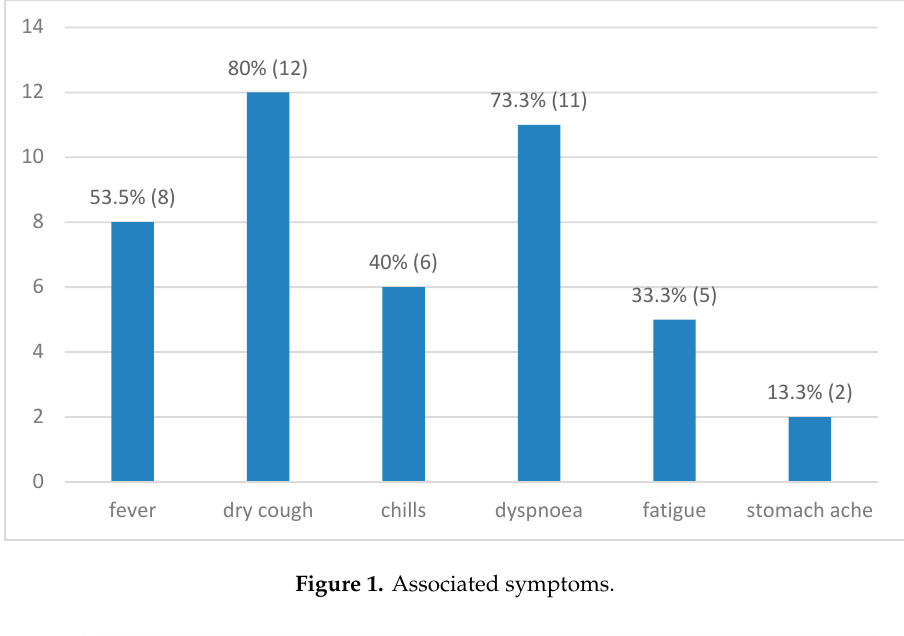
Figure 1. Associated symptoms.